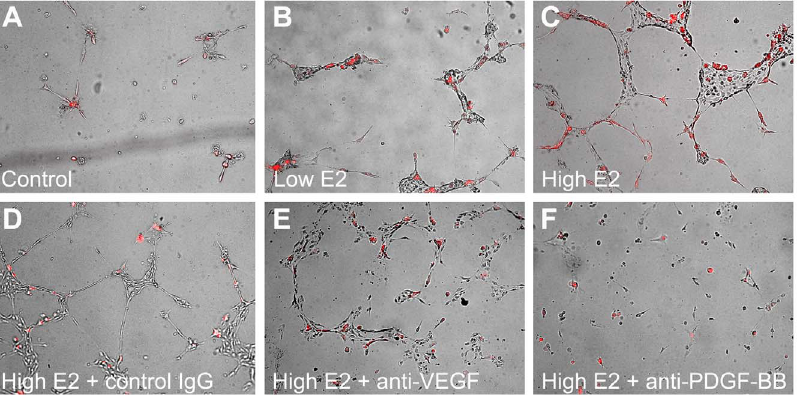
Figure 6. Brain endothelial cells bEnd.3 and brain vascular pericytes HBVP (red) do not form 3-D networks under basal conditions (A) . Low diestrous E2 level (10 2 11 M) only marginally improves pericyte association with endothelial cells (B). In the presence of high estrous E2 level (10 2 10 M) bEnd.3 and HBVP form vast 3-D networks within 24 h (C). Neither control IgG (D) nor function blocking anti-VEGF antibody (E) inhibit microtubular network formation by brain endothelial cells and brain vascular pericytes in response to high E2 concentration. Function blocking anti- PDGF-BB antibody completely abolishes the ability of brain endothelial cells and brain vascular pericytes to form microtubular networks in response to high E2 level